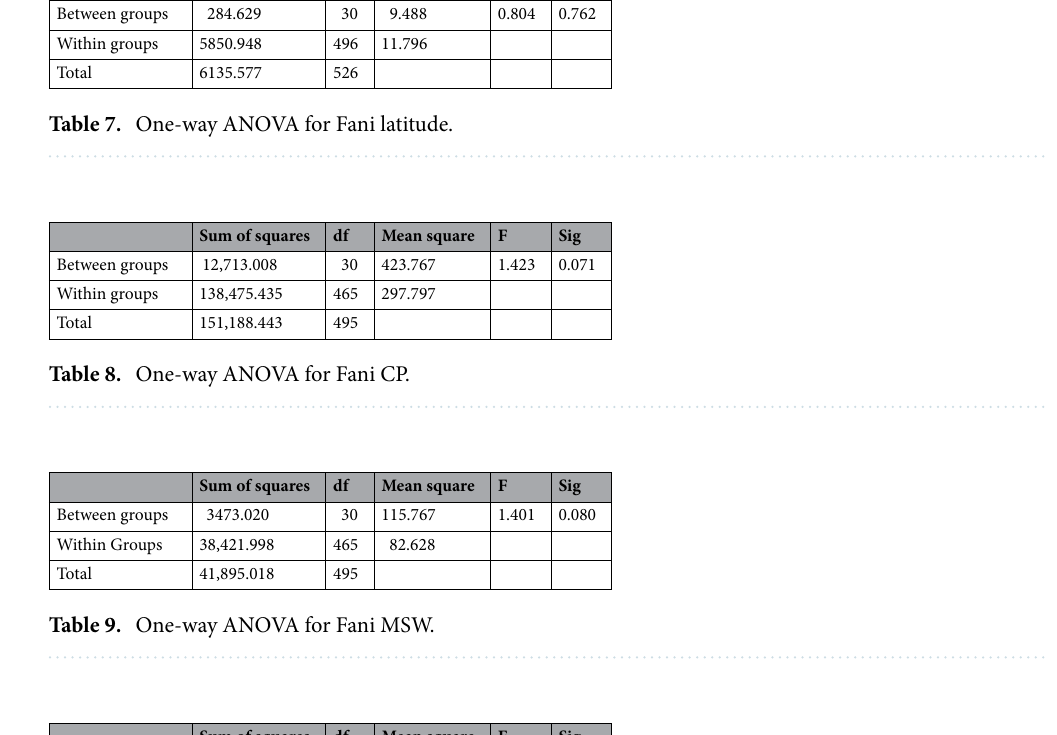
Sum of squares df Mean square F Sig